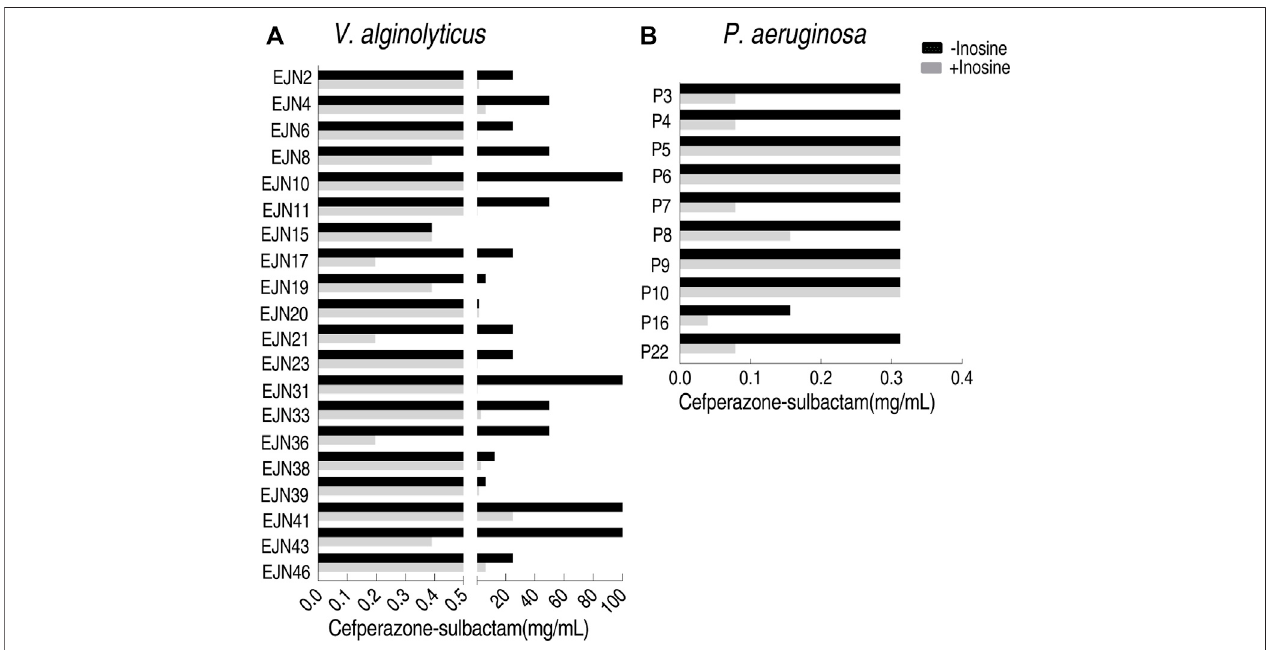
FIGURE8 | MBC test of10 clinically isolated P. aeruginosa strains in M9 medium with and without 5 mM inosine plus SCF.